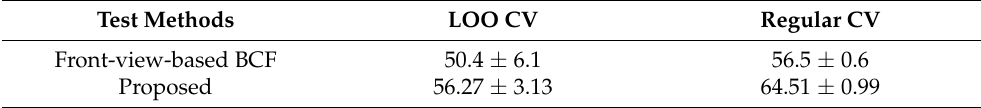
Table 5. Comparison of proposed technique with earlier techniques in leave-one-subject-out CV test on HUST-ASL